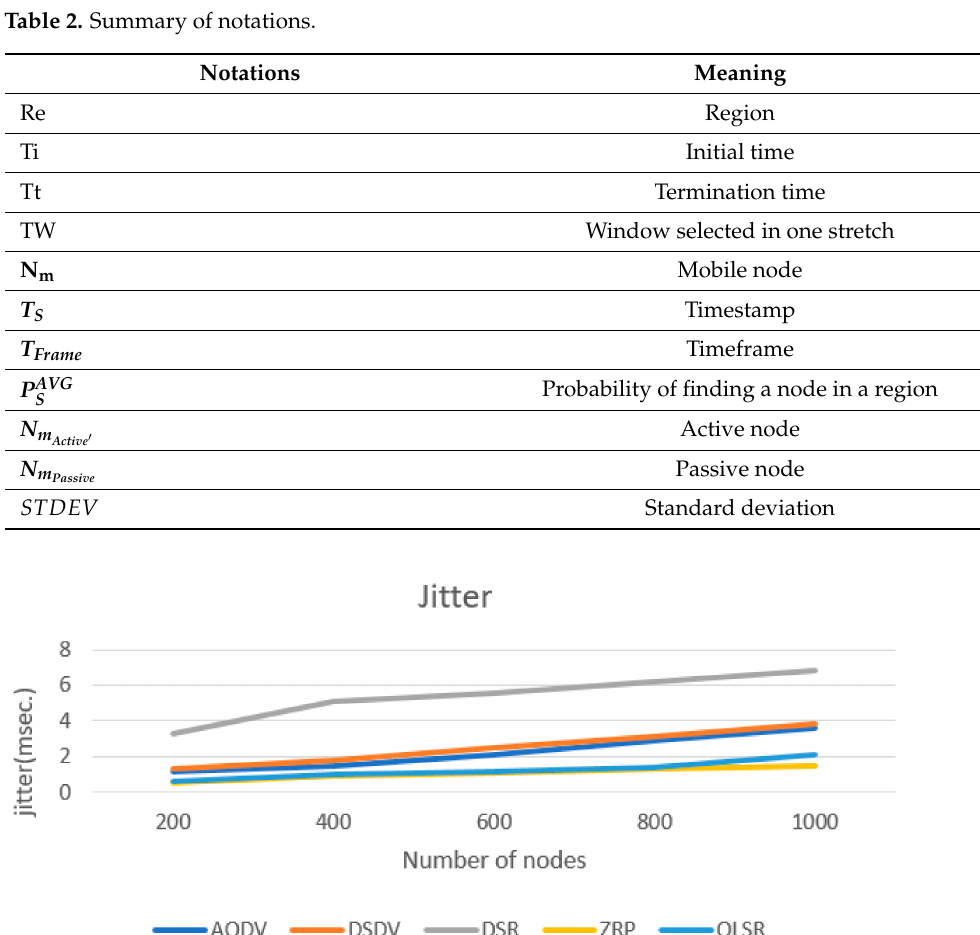
Figure 3. Comparative analysis of jitter in 200–1000-node networks using the proposed scheme over five MANET routing protocols.